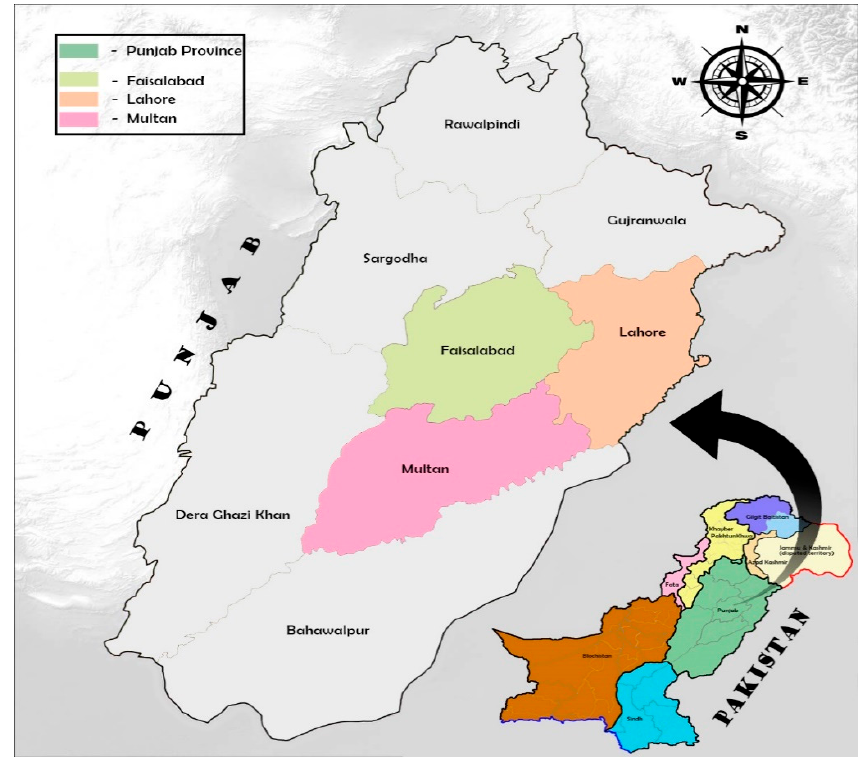
Figure 2. Survey map of selected cities in Punjab province, Pakistan (source: authors’ own).